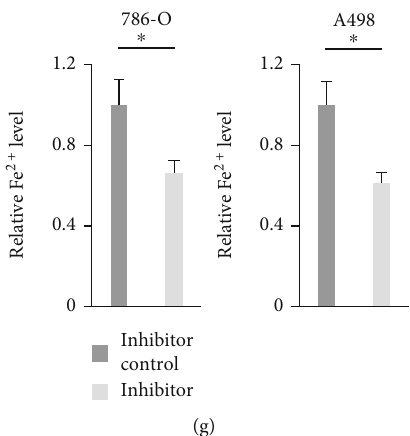
Figure 3: Suppression of miR-4735-3p reduces ferroptosis of human ccRCC cell lines. (a) Relative expression of miR-4735-3p in human ccRCC cell lines treated with the miR-4735-3p inhibitor or inhibitor control. (b) Cell viability was examined by the MTT method. (c) Relative LDH level in the medium from the miR-4735-3p inhibitor or inhibitor control-treated ccRCC cells. (d and e) Relative ROS and MDA levels. (f and g) Relative intracellular iron and Fe 2+ levels. N = 6 per group. All data were expressed as the mean ± SD ; ∗ P < 0 : 05 was considered signi fi